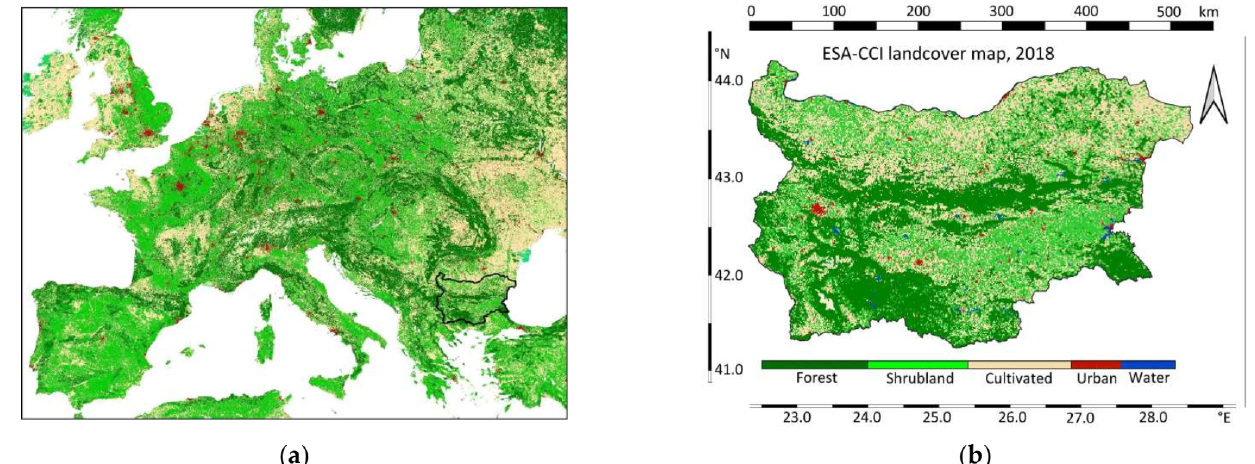
Figure 1. Geographical distribution of the vegetation cover types according to the ESA-CCI Land Cover database 2018 over ( a ) Europe; ( b ) Bulgaria, SE Europe, reclassified for the purposes of the study into three categories: forest, shrubland,